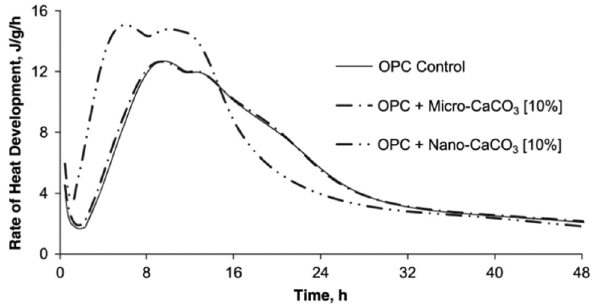
Figure 12: Conduction calorimetry results for OPC control and OPC with the addition of 10% micro - CaCO 3 and nano - CaCO 3 [ 115 ]